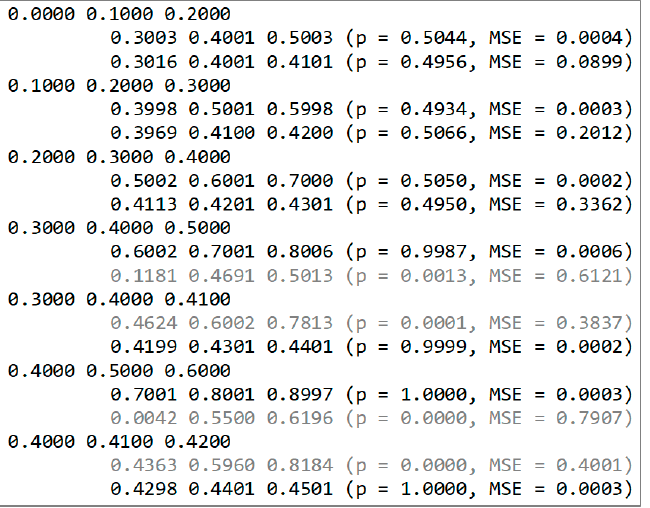
Figure 10. The prediction results for the symmetric bimodal problem.